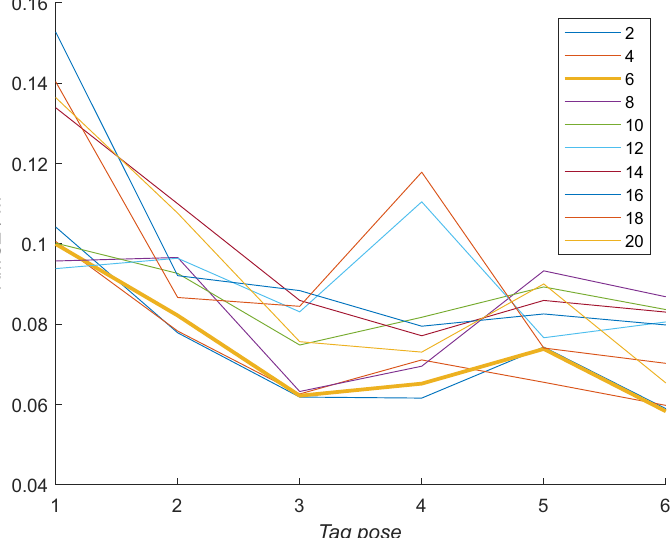
Figure 14. Results from neural networks with a different number of neurons in the hidden layer, all trained with the same training data. The RMSE is displayed for each tag’s pose. The numbers in the legend represent the number of used neurons in the hidden layers.